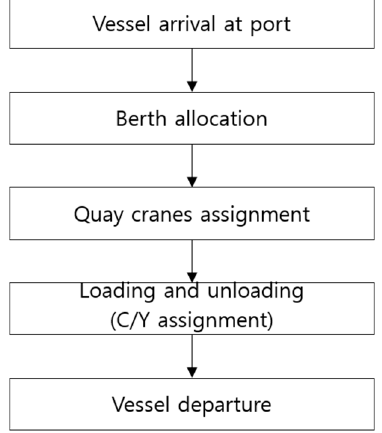
Figure 2. Port-container terminal process.